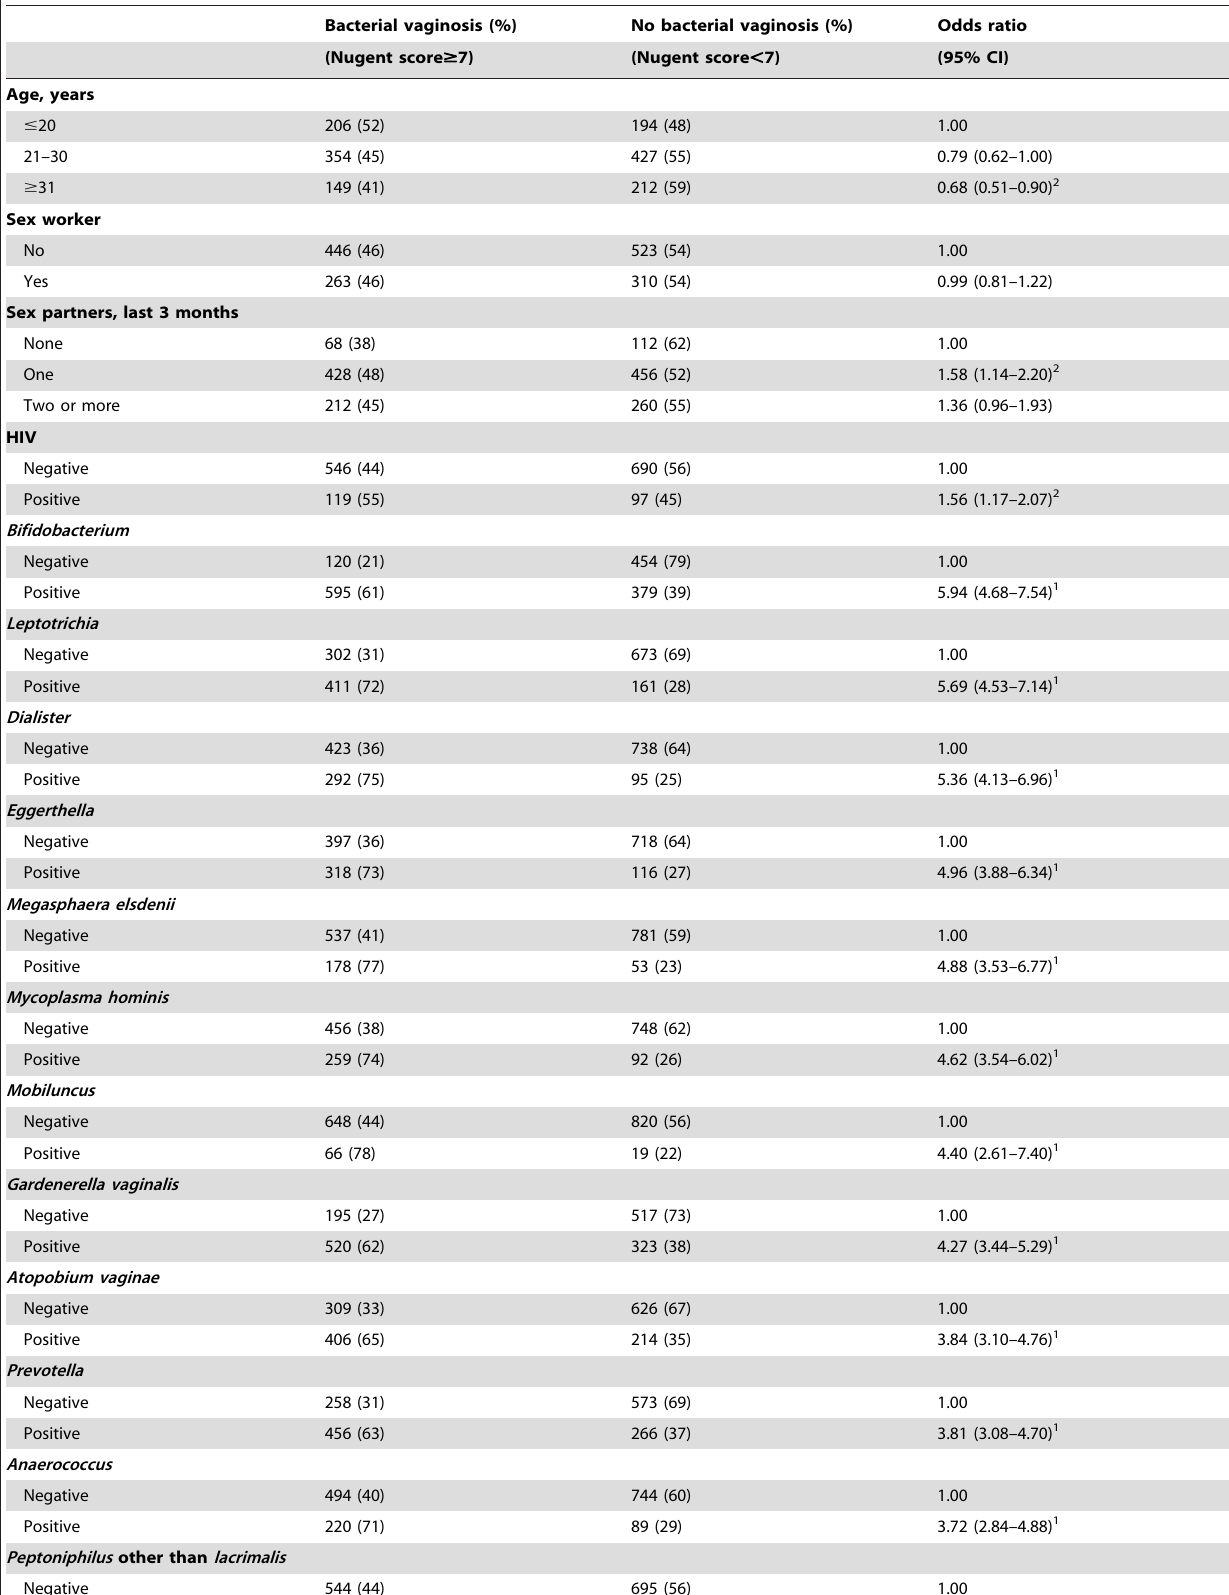
Table 3. Correlates of bacterial vaginosis in univariate